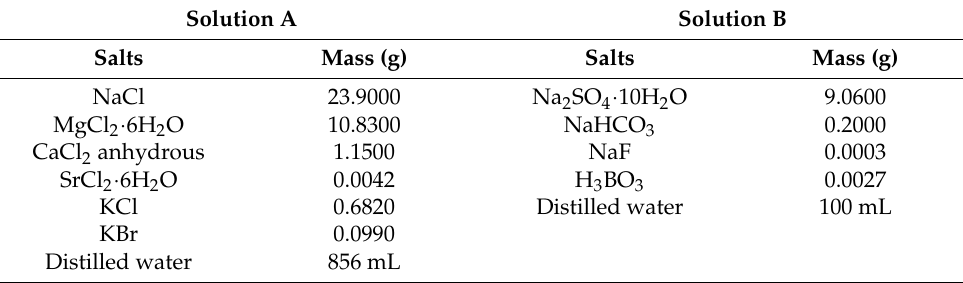
Table 1. Components of synthetic seawater at a salinity of 35